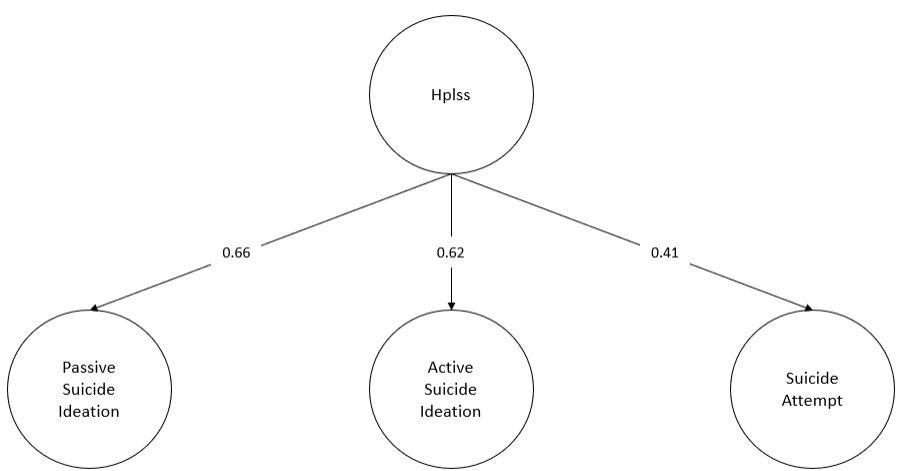
Figure 4. Structural model: frequency. Hplss: hopelessness. Standardised regression coefficients. For the sake of clarity, observable indicators for each latent factor considered in the model are omitted from the diagram. Likewise, the interfactor correlations between the suicide severity factors were omitted.